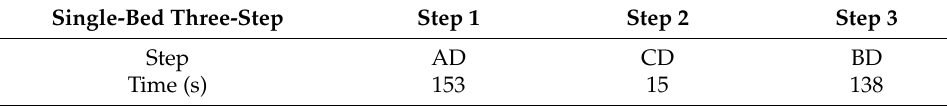
Figure 2. Steps of the single-bed three-step PSA process. Table 2. Step time of the single-bed three-step PSA process. Table 2. Step time of the single-bed three-step PSA process.